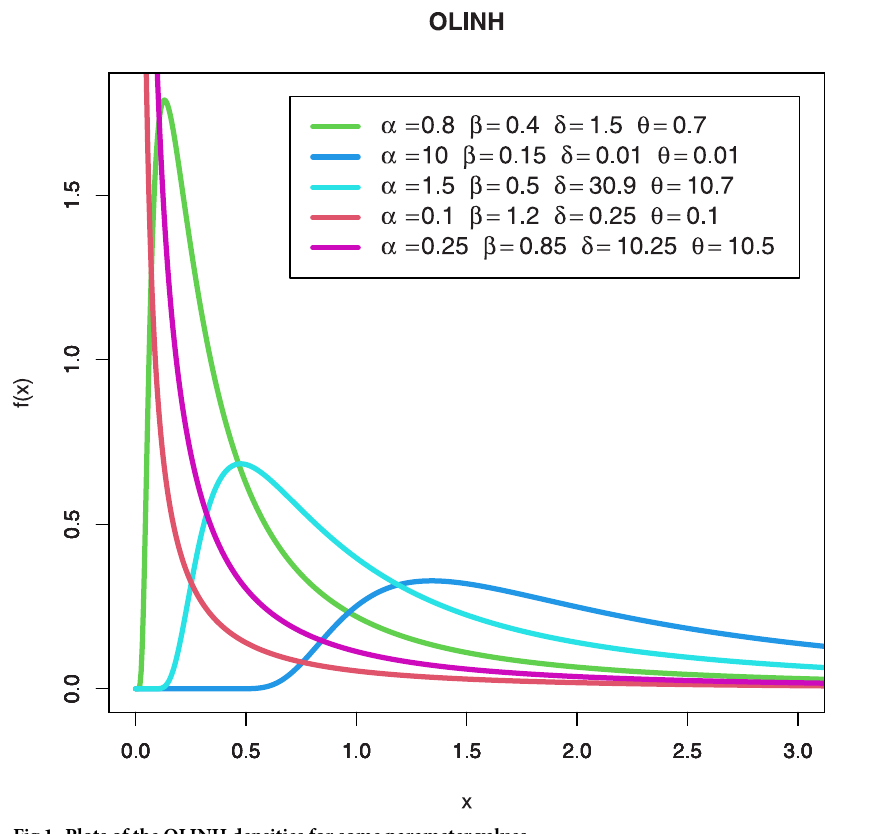
Fig 1. Plots of the OLINH densities for some parameter